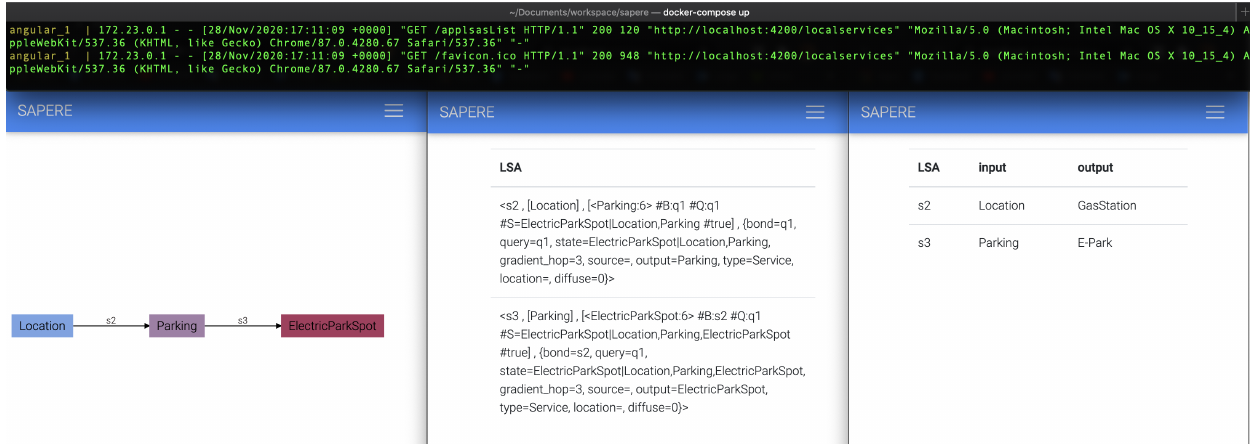
Figure 13. The experiment of the electric car parking scenario using the semantic